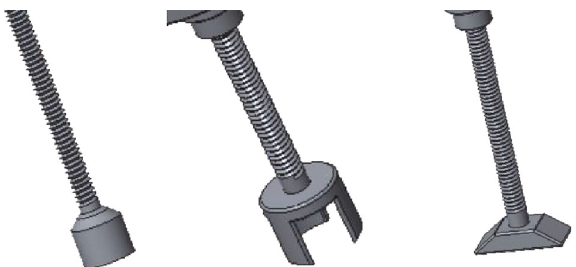
Figure 4: The ball and its location.